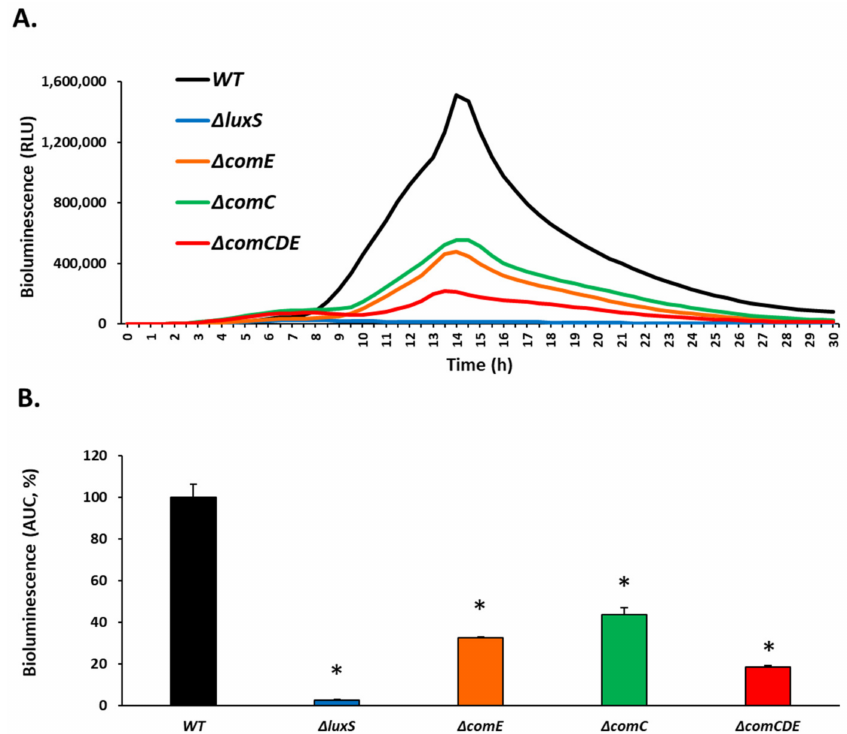
Figure 9. Measuring the AI-2 content in the condition medium (CM) of the various S. mutans strains. ( A ). The bioluminescence induced in MM77 Vibrio harveyi strain by the condition medium collected from the various S. mutans strains (WT, ∆ luxS , ∆ comC , ∆ comE and ∆ comCDE ) was measured for 30 h. The bioluminescence was normalized to differences in bacterial growth by concomitantly measuring the optical density at 595 nm. n = 3. ( B ). The relative bioluminescence calculated as the area under the curve (AUC) of the graph presented in ( A ). n = 3; * p < 0.05.